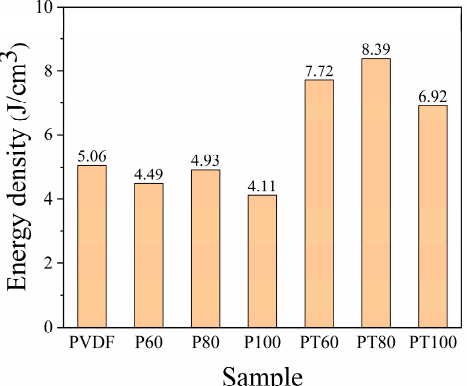
Figure 10 . Energy storage density of PVDF and PTFE–c–PVDF . Figure 10. Energy storage density of PVDF and